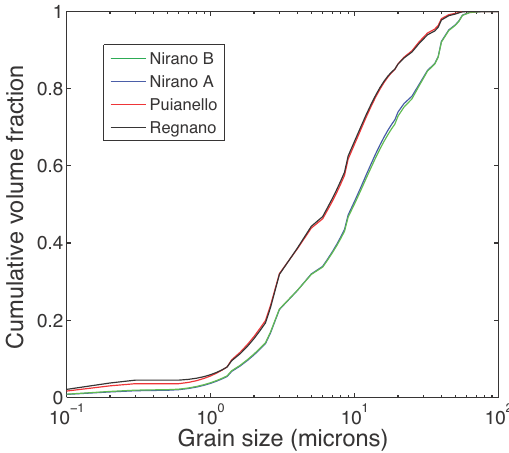
691 Fig. 8. Cumulative grain size distribution measured by laser diffrac- Figure 8: Cumulative grain size distribution measured by laser diffraction for all 4 692 tion for all 4 mud volcanoes. Each curve is the mean of three sam- mud volcanoes. Each curve is the mean of three samples. Data for Nirano A and B 693 overlap; data for Puianello and Regnano overlap as well. 694 ples. Data for Nirano A and B overlap; data for Puianello and Reg- 695 nano overlap as well.